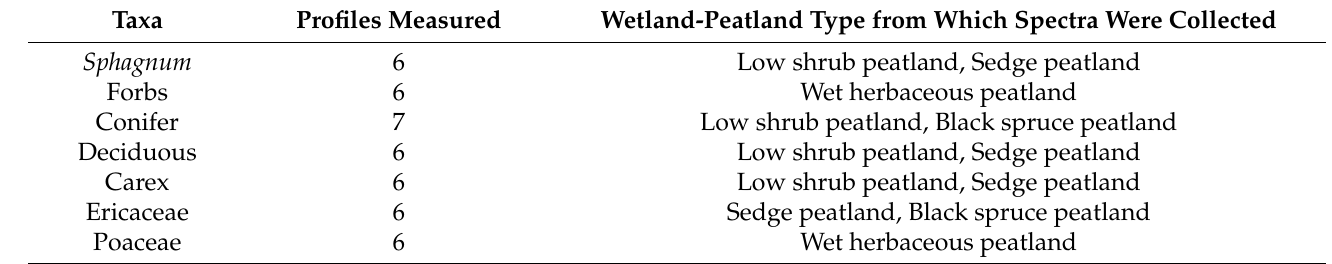
Table A2. Number of spectral profiles for each Plant Functional Type, and from which wetland classes.